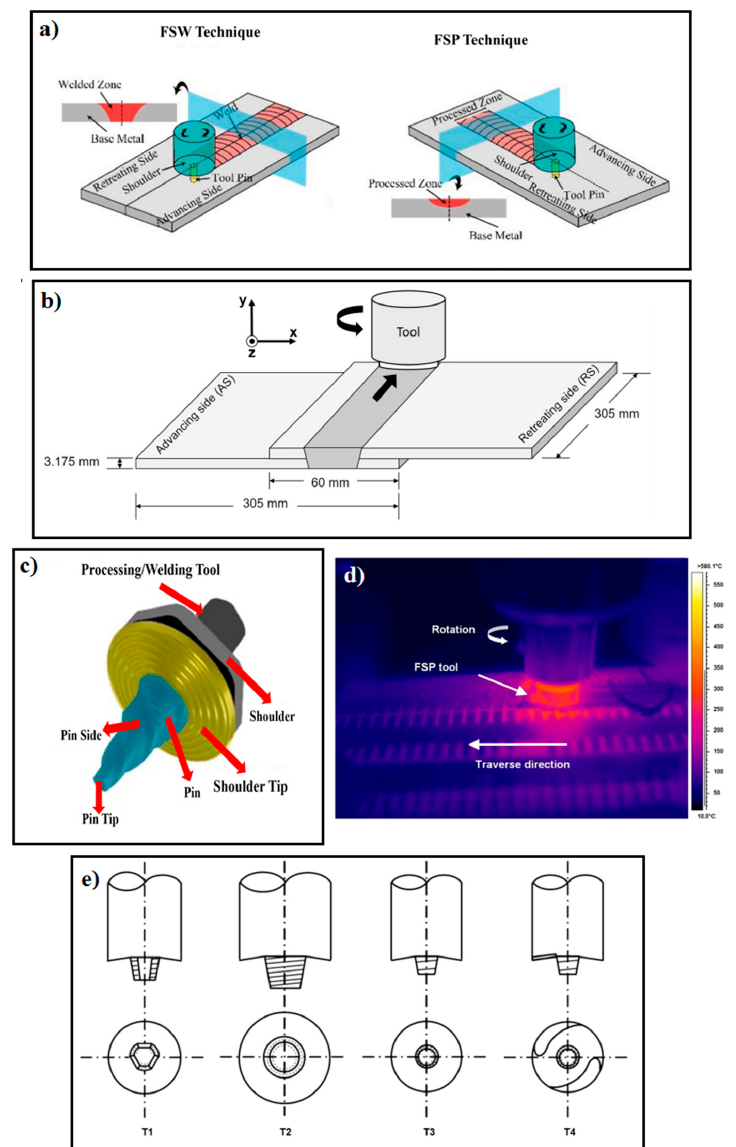
Figure 1. ( a ) Schematic representation of FSW technique, and FSP technique (Adapted from [27]). ( b ) Lap joint configuration of the 2024-T3 AlClad FSW assembly (Reprinted with permission from ref. [10]. Copyright 2020 Elsevier Ltd.). ( c ) Rotation tool in FSW/FSP technique (Adapted from [27]). ( d ) IR image of FSP tool during processing (Reprinted with permission from ref. [7]. Copyright 2016 Elsevier B.V.). ( e ) Different FSP tool pin profiles (Reprinted with permission from ref. [7]. Copyright 2016 Elsevier